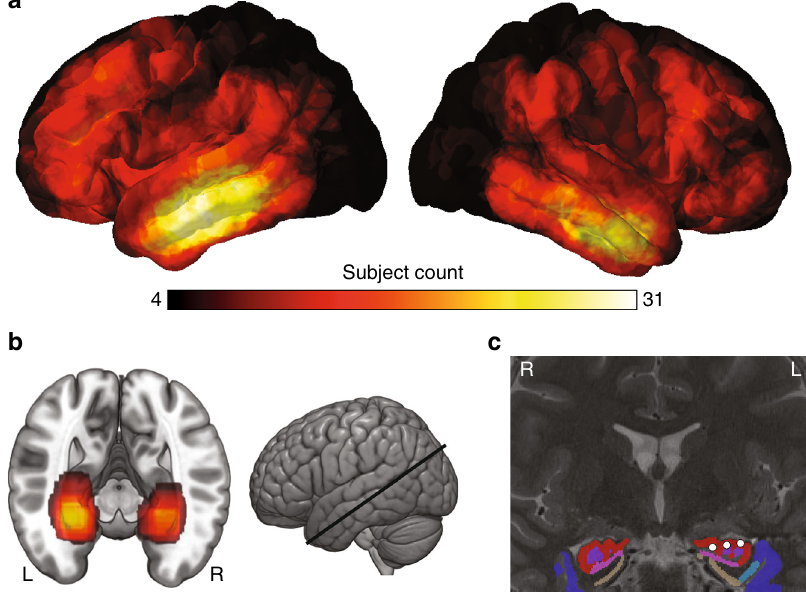
Fig. 2 Electrode characteristics. a Colored brain surfaces showing the number of subjects contributing electrodes to each neocortical location. Electrodes contribute to a location if they are within 12.5 mm of a given point on the brain surface. Black coloring indicates coverage from four or less subjects. b A cross section along the longitudinal axis of the hippocampus (slice location shown to the right) indicating the number of subjects contributing electrodes to each location. Electrodes contribute to a location if they are within 3 mm of a given voxel. c Coronal MRI image showing electrode positions from one example patient with depth electrodes. Individual medial temporal lobe (MTL) regions are colored using our automated segmentation procedure. Three electrodes in region CA1 (red) are shown in white. CA1: red, subiculum: pink, dentate gyrus: purple, entorhinal cortex: tan, BA 35: light blue, BA 36: dark